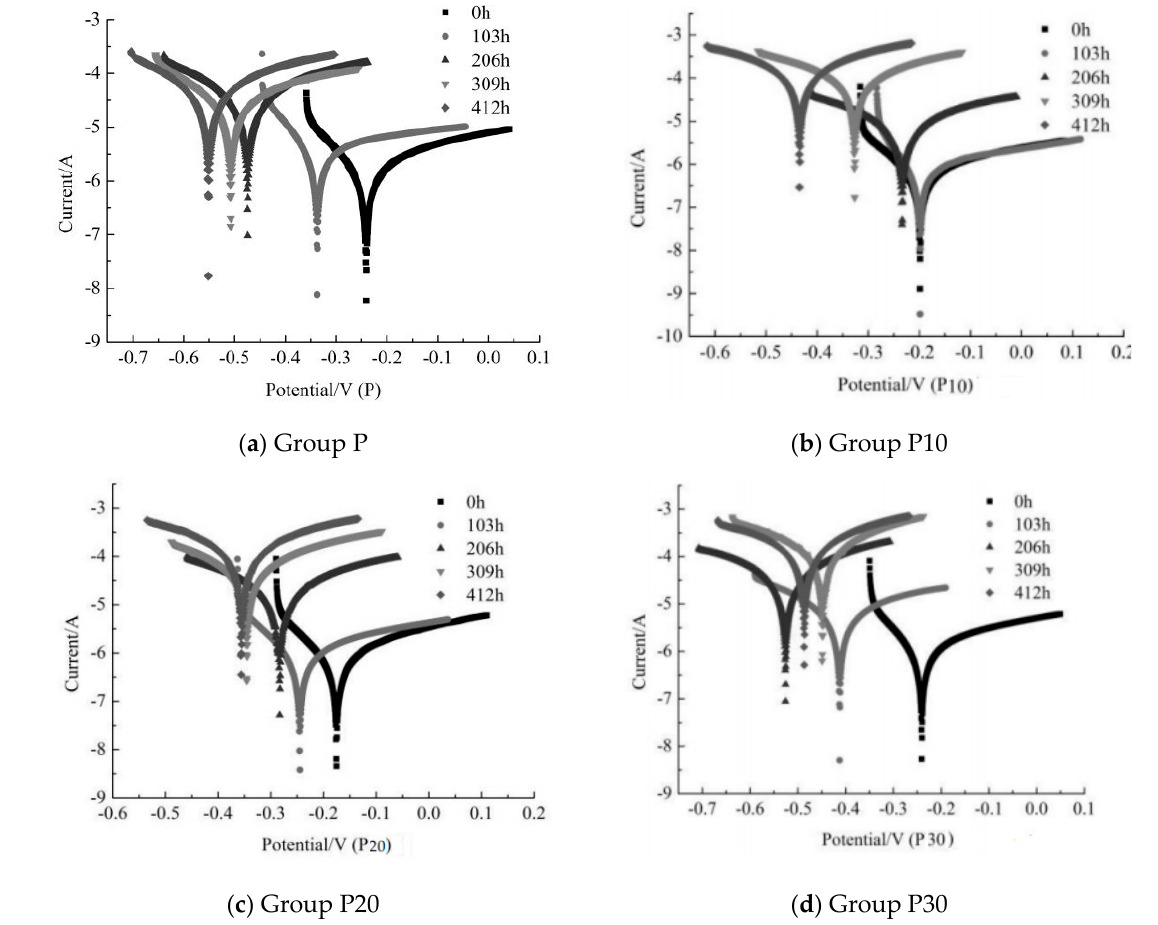
Figure 4. Polarization curves of reinforced concrete with different copper tailings. ( a ) Polarization curves of Group P; ( b ) polarization curves of Group P10; ( c ) polarization curves of Group P20; ( d ) polarization curves of Group P30.